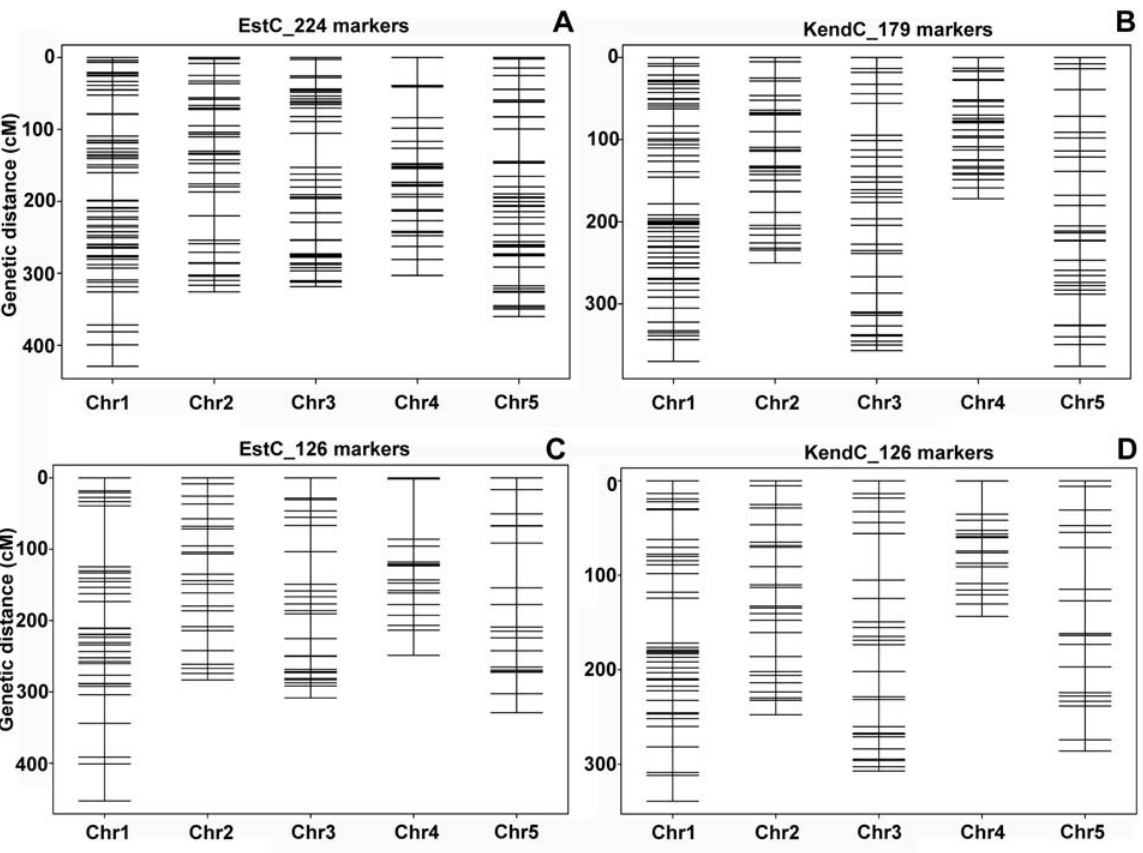
Figure 2. Genetic maps of AI-RIL populations. (A) Genetic map of EstC AI-RILs generated from the genotypes of 279 plants at 224 markers. (B) Genetic map of KendC AI-RILs generated using genotypes of 282 plants at 179 markers. (C, D) Genetic maps generated using the common 126 markers for the EstC (C) and KendC (D) populations. Note population-specific patterns of increases in genetic distances.